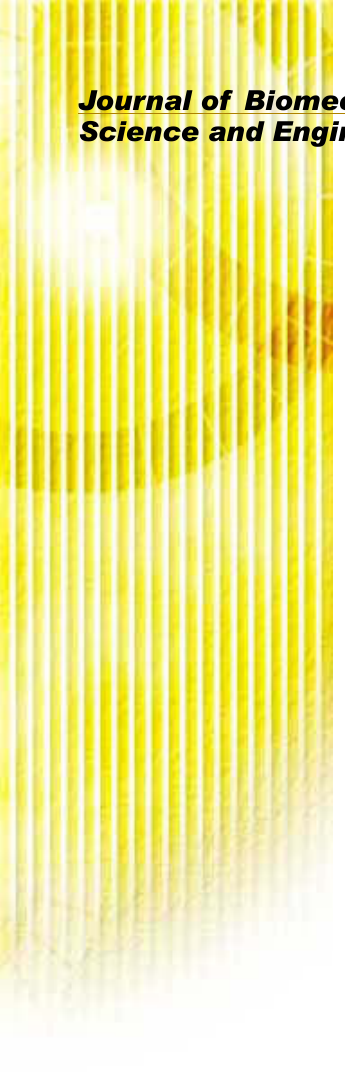
Fig.8 Frequency patterns of normalized phase velocity at three different sampling interval ( dt =10ms, dt =1ms and dt =0.01ms). Data point are the mean and bars standard error of ten noise simulation.